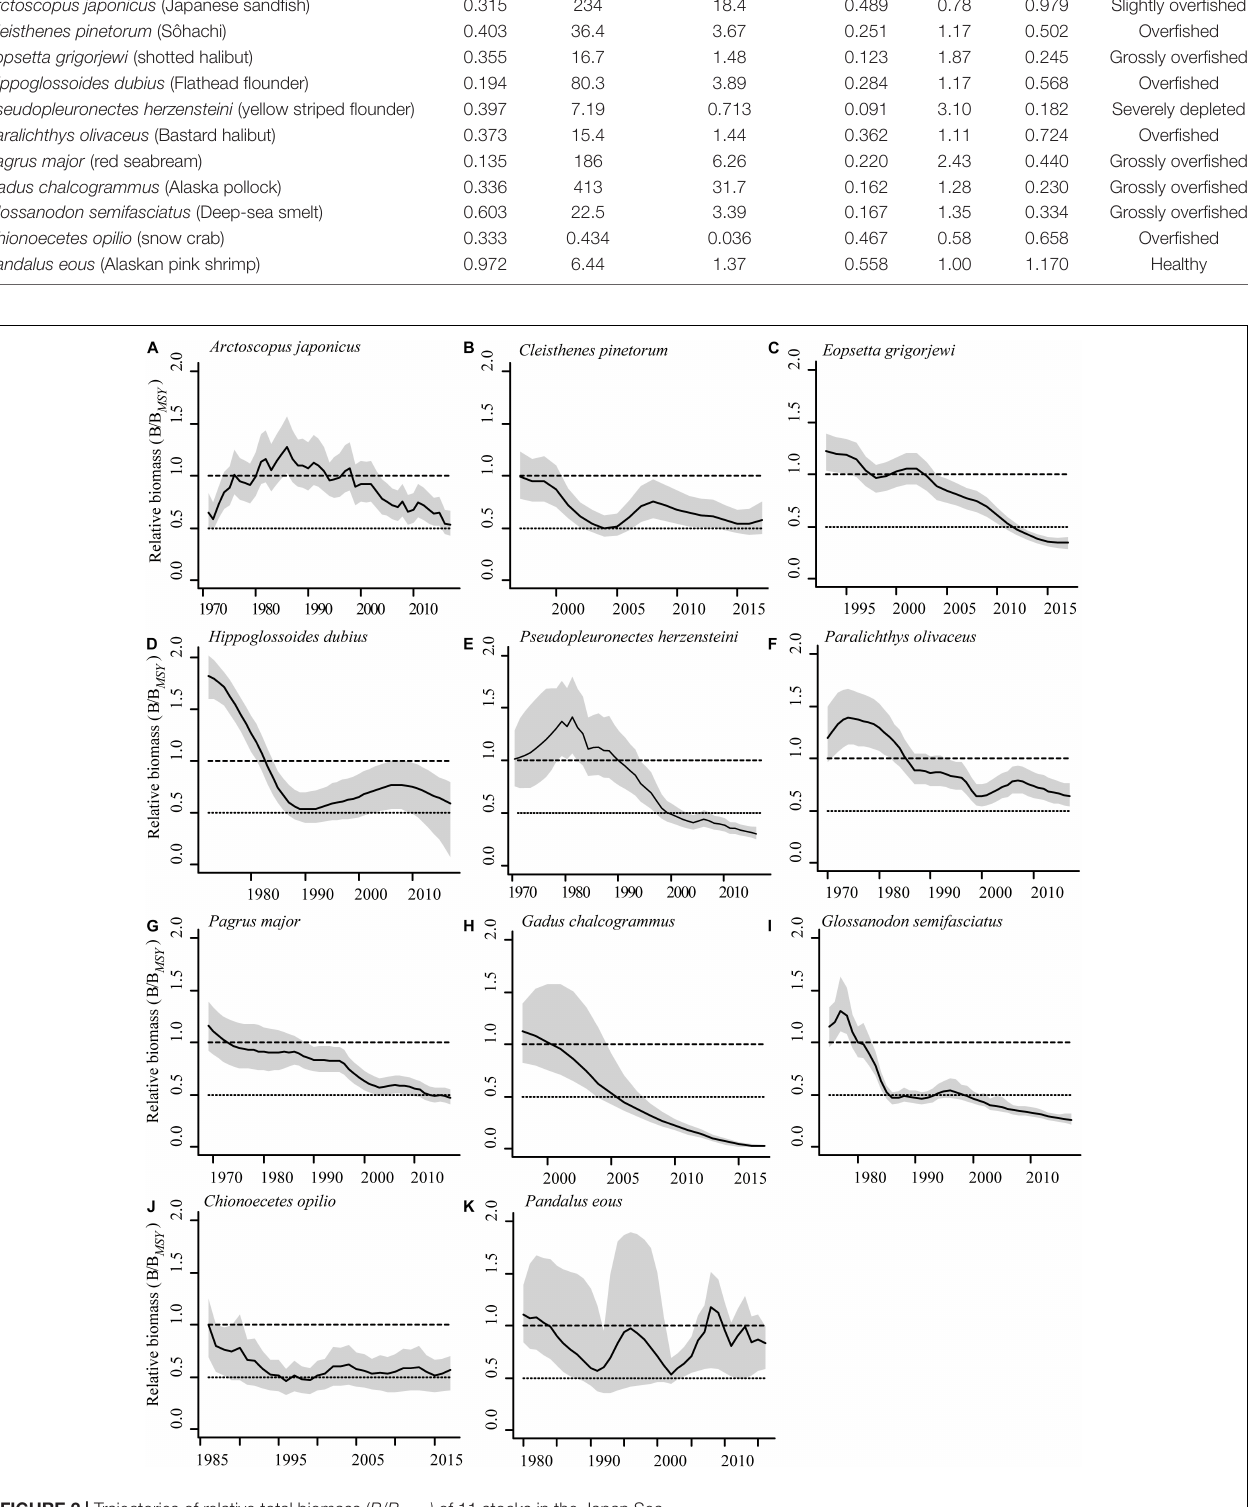
Frontiers in Marine Science |